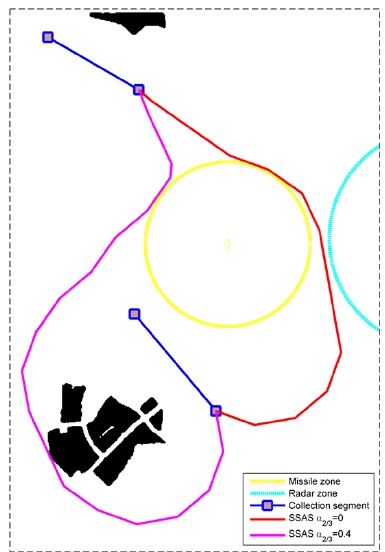
Figure 18. Designed sub-paths with different α k in test case